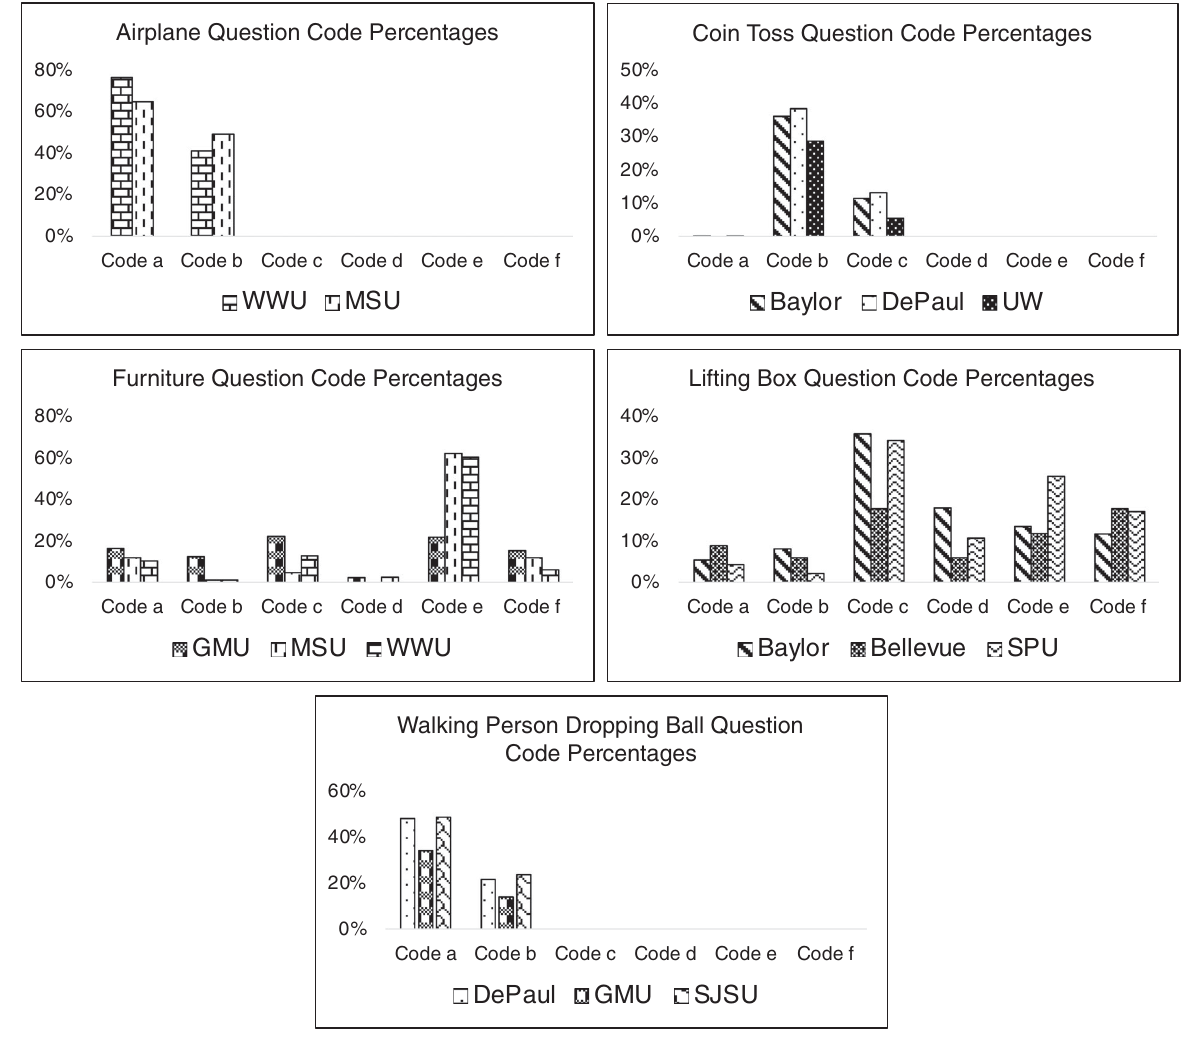
FIG. 10. Fraction of student responses using resources (a) through (f), by